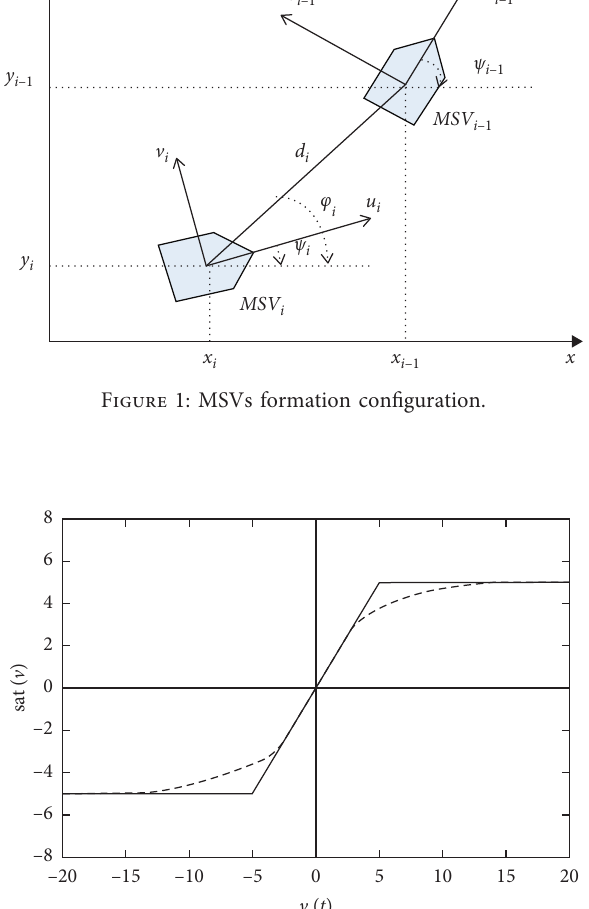
Figure 2: Saturation (dotted line: approximate function; solid line: sat(v)).